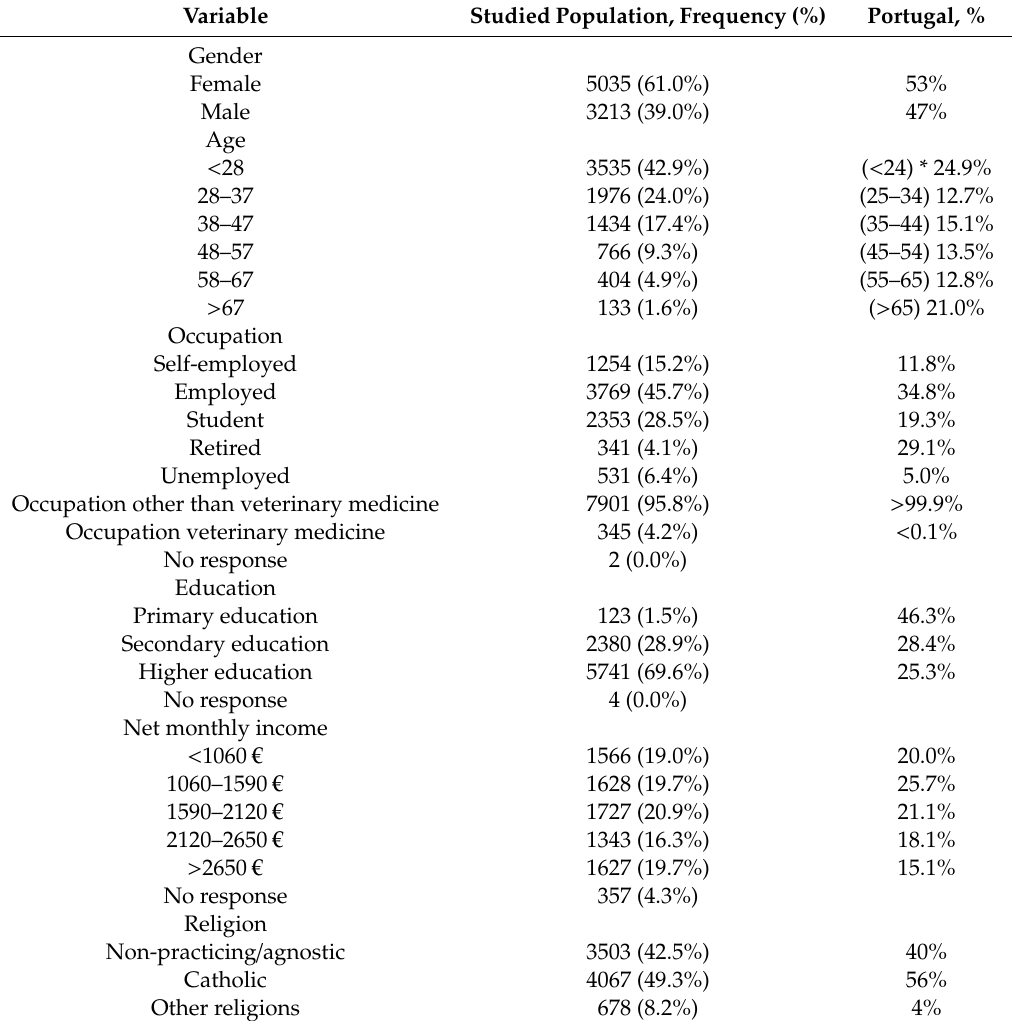
Table 1. Descriptive analysis of the survey respondents and the general population of Portugal (N = 8248